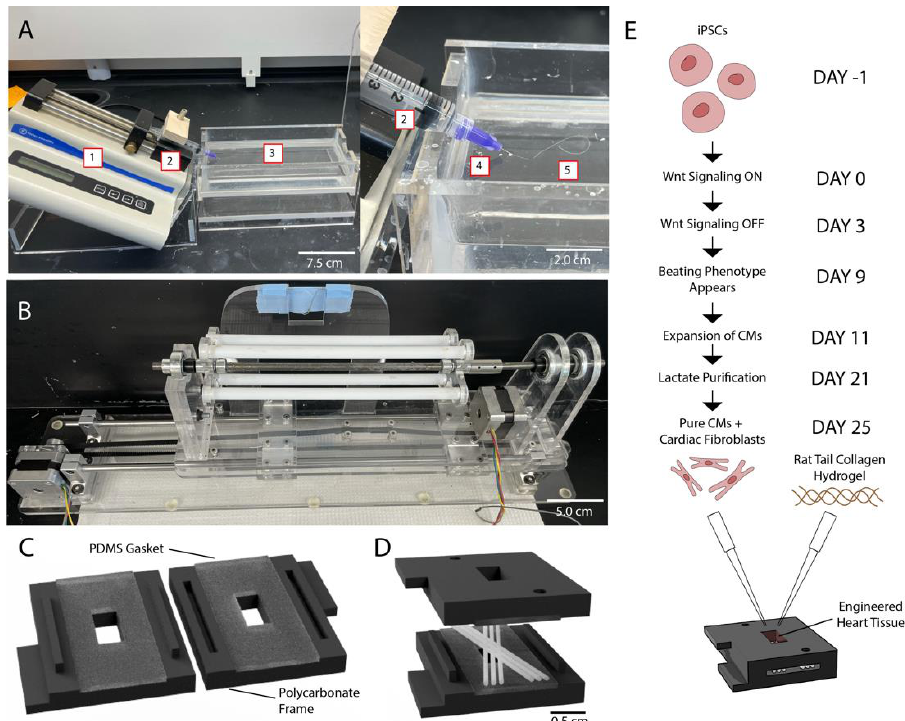
Figure 1. Custom production process allows for facile fabrication of fibrous PCL scaffolds for engineered heart tissue. ( A ) Image of wet-spinning process: a syringe pump {1} extrudes PCL solution {2} into a coagulating ethanol bath {3} through a blunt needle {4} to precipitate a solid PCL fiber {5}. ( B ) Image of Arduino-controlled mandrel. Mandrel rotates and translates to position fibers into a scaffold with user-defined spacing and angle inputs. ( C ) PDMS gaskets are embedded in 3D-printed polycarbonate press-fit capture frames and autoclaved. ( D ) Capture frames are used to remove fibers from the mandrel and prepare scaffolds for tissue culture. ( E ) Differentiation of hiPSC-CMs and formation of engineered tissues: iPSCs are differentiated into CMs using a Wnt signaling pathway, expanded, purified, and combined with a collagen hydrogel to produce engineered heart